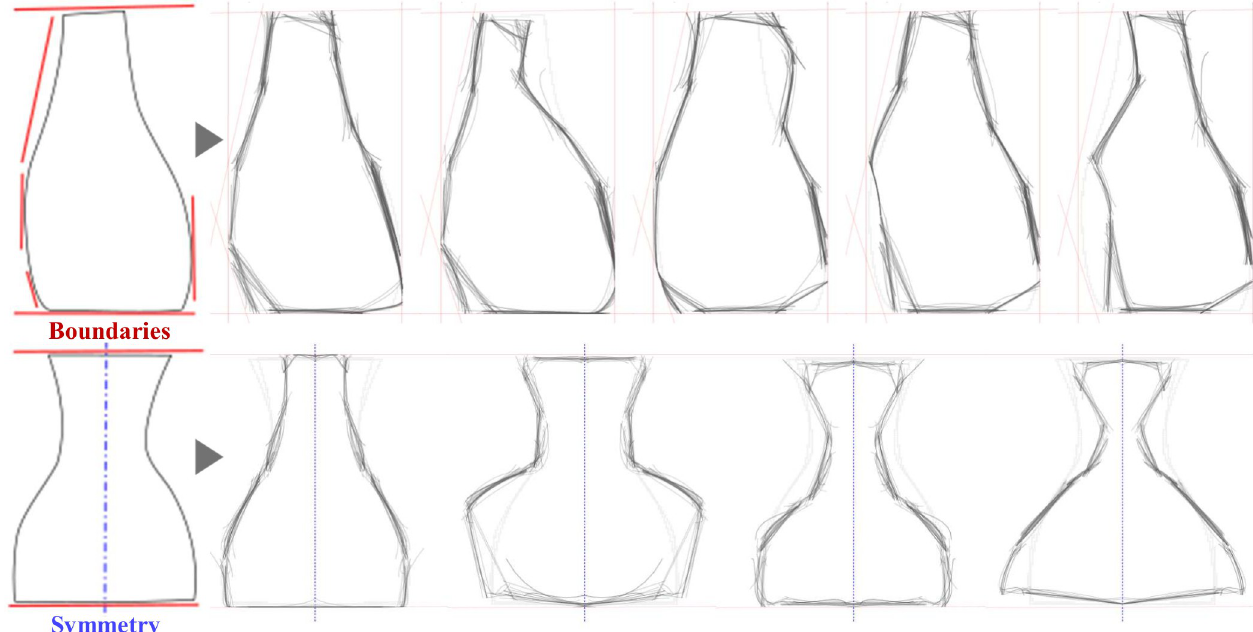
Fig 5. Examples of drawn boundaries and a symmetry axis to guide the exploration